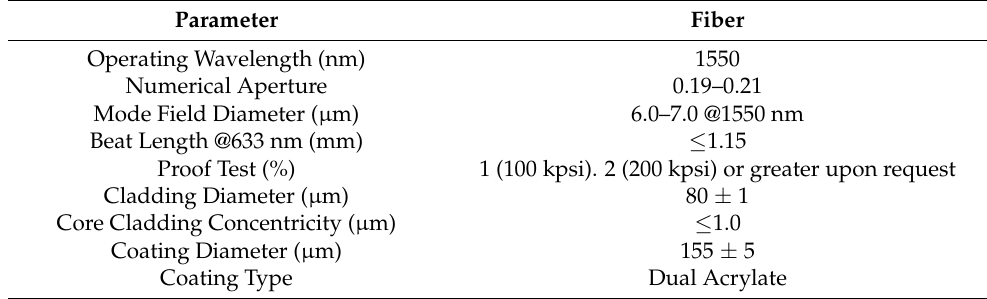
Table 1. Technical specifications of